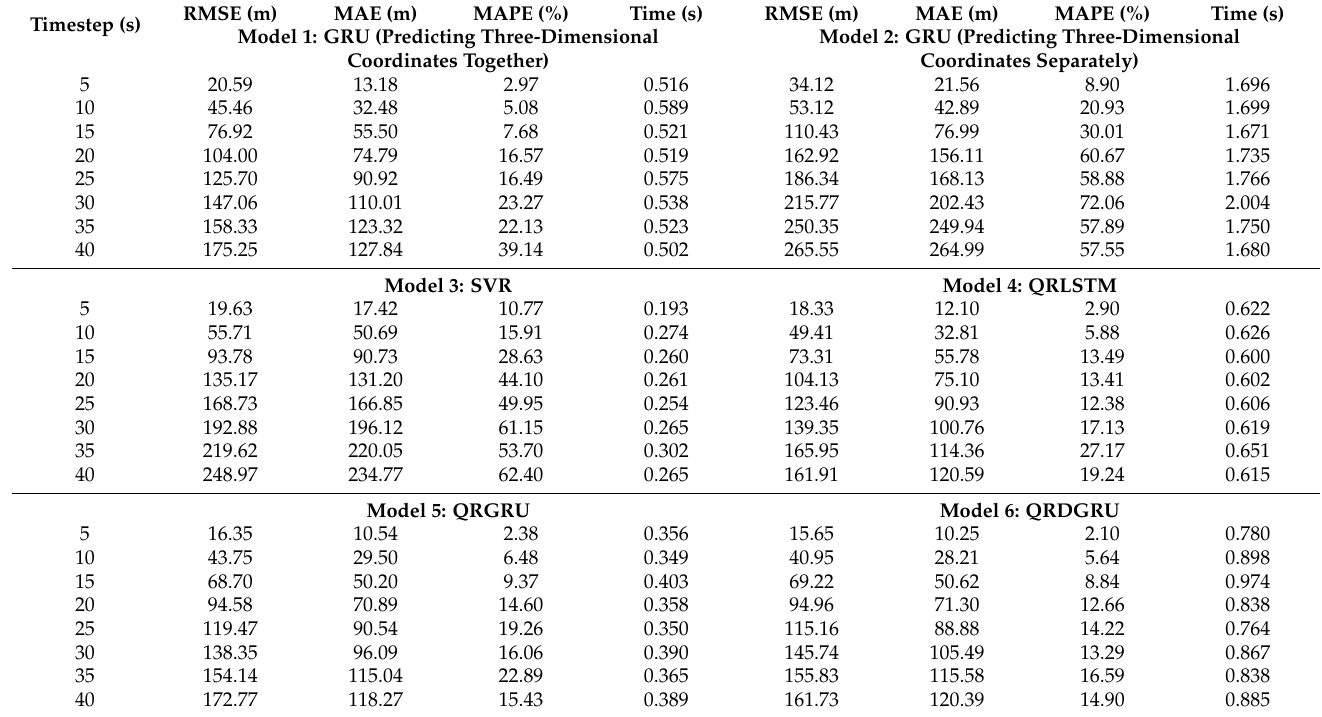
Table 6. Prediction performance under different timesteps for the six models